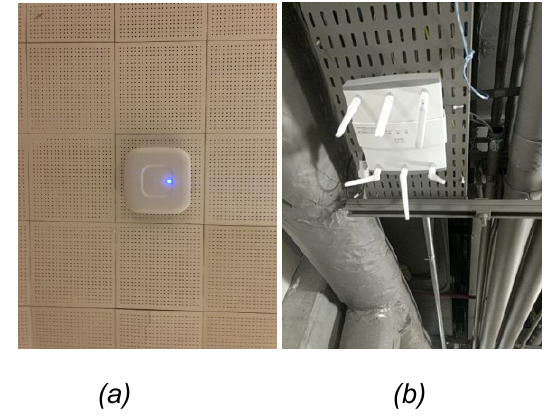
Figure 4: Router from round 3: (a) Cory Hall; (b) Soda Hall.